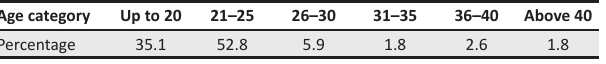
TABLE 3: Age groups of respondents.